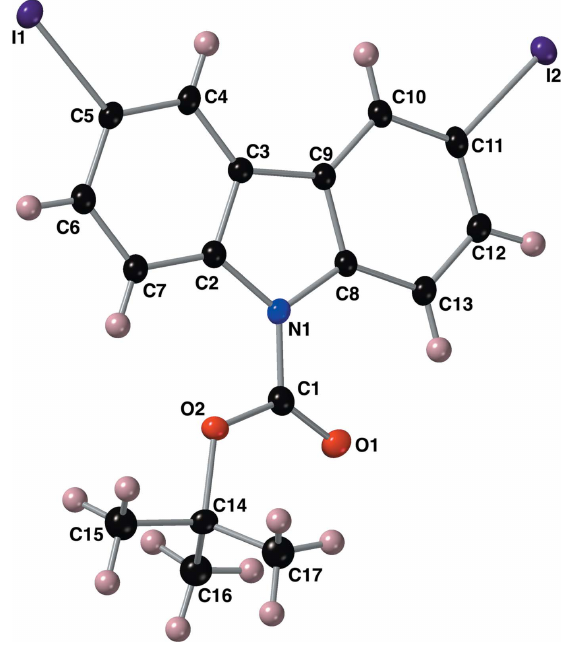
Figure 1 The molecular structure of compound I , with the atom-labelling scheme. Displacement ellipsoids are drawn at the 50% probability level using standard CPK colors (I =